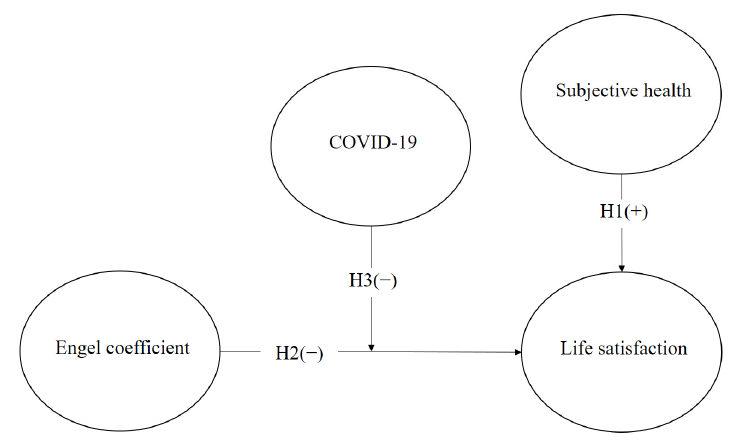
Figure 1. Research model.